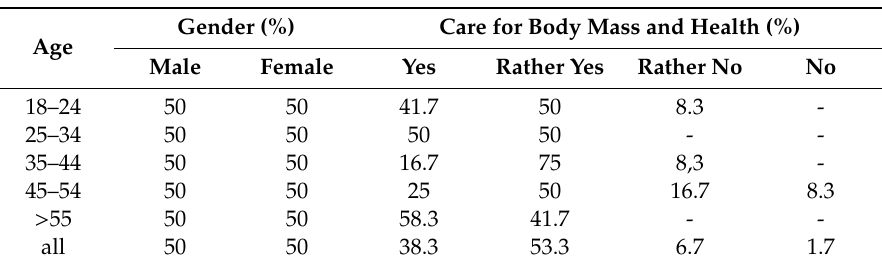
Table 3. Characteristics of the consumer